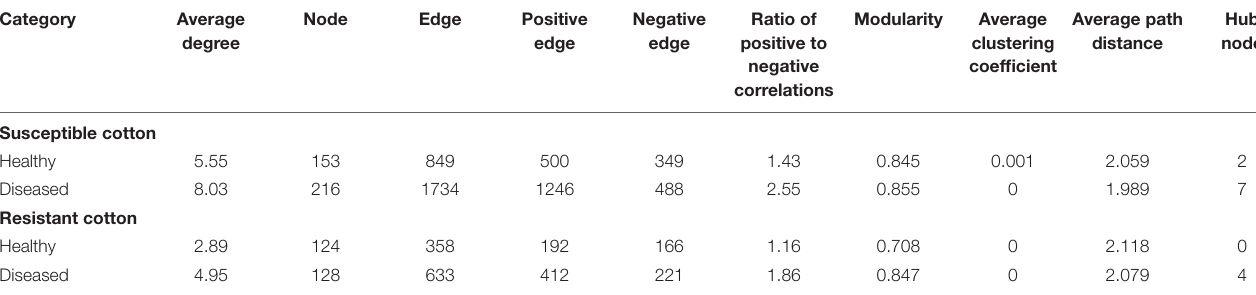
TABLE 1 | Topological properties of the co-occurrence networks of healthy and diseased cotton plants. Category Average